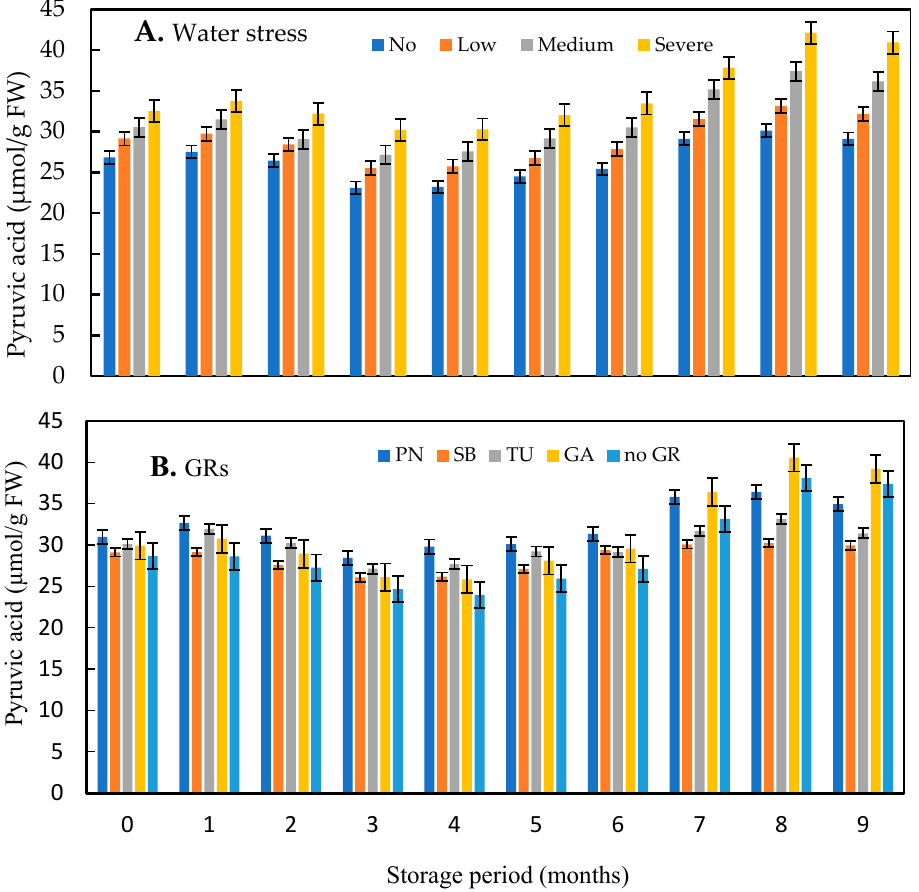
Figure 5. Effect of water stress on pyruvic acid ( A ) and plant bioregulators ( B ) across nine months of storage.